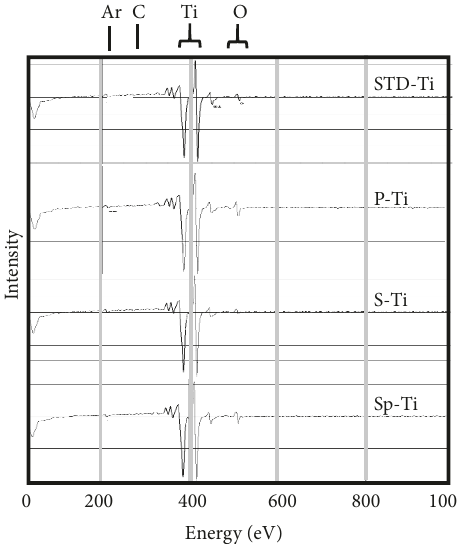
Figure 5: AES spectra of bottom layer after depth direction analysis of each Ti plate.